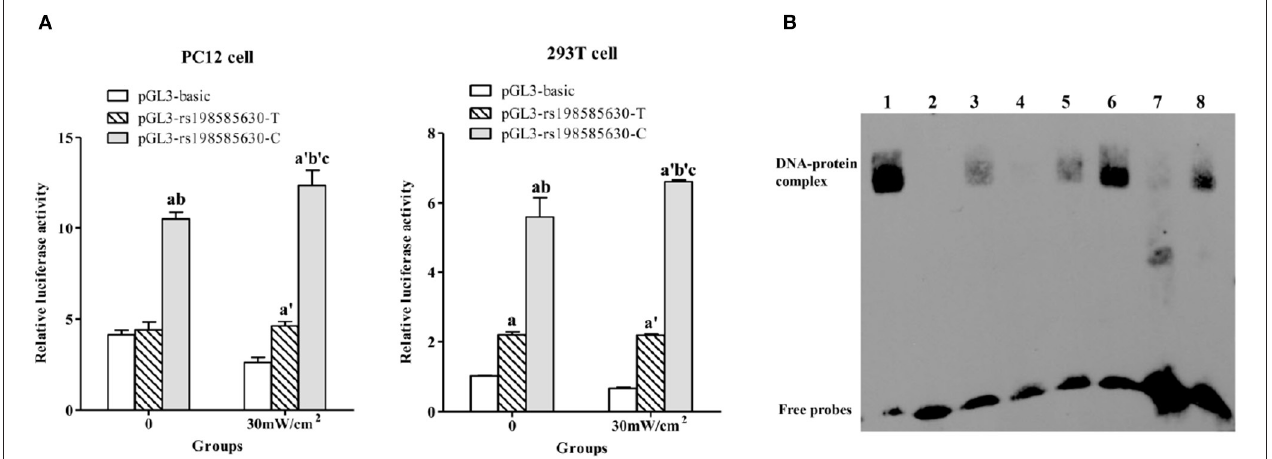
FIGURE 2 | Functional analysis of rs198585630 and its association with the alterations induced by microwave exposure. (A) Relative luciferase activity driven by either the 5-HT 1A receptor promoter − 215T or C allele-pGL3 plasmid in PC12 and 293T cells treated with or without 30 mW/cm 2 microwave exposure. a P < 0.05 vs. pGL3-basic-0, b P < 0.05 vs. pGL3-T-0, c P < 0.05 vs. pGL3-C-0, a ′ P < 0.05 vs. pGL3-basic-30 mW/cm 2 , b ′ P < 0.05 vs. pGL3-T-30 mW/cm 2 . (B) Analysis of 5-HT 1A receptor − 215 T/C oligonucleotides incubated with nuclear extracts derived from PC12 cells by the EMSA. Lane 1: labeled CREB probe with nuclear extract from control cells; lane 2: labeled C probe without nuclear extract; lane 3: labeled C probe with nuclear extract from control cells; lane 4: labeled C probe and 200-fold unlabeled C probe with nuclear extract from control cells; lane 5: labeled C probe and 200-fold unlabeled T probe with nuclear extract from control cells; lane 6: labeled C probe with nuclear extract from 30 mW/cm 2 -exposed cells; lane 7: labeled T probe with nuclear extract from control cells; lane 8: labeled T probe with nuclear extract from 30 mW/cm 2 -exposed